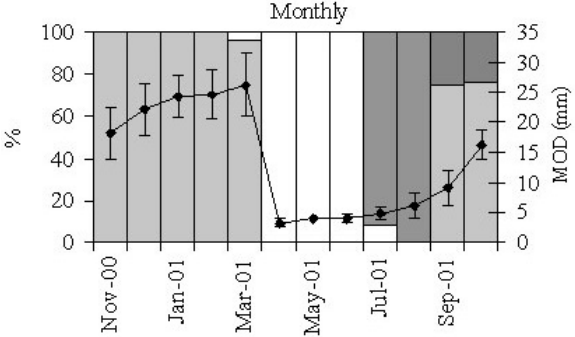
F IG . 5. – Monthly evolution of maturity stages in adult females of T. torpedo ( (cid:3) mature; (cid:2) early pregnant; (cid:3) late pregnant; (cid:3) post- pregnant) and monthly variation of mean (± S.D.) maximun oocyte diameter (MOD) in adult females of T. torpedo.